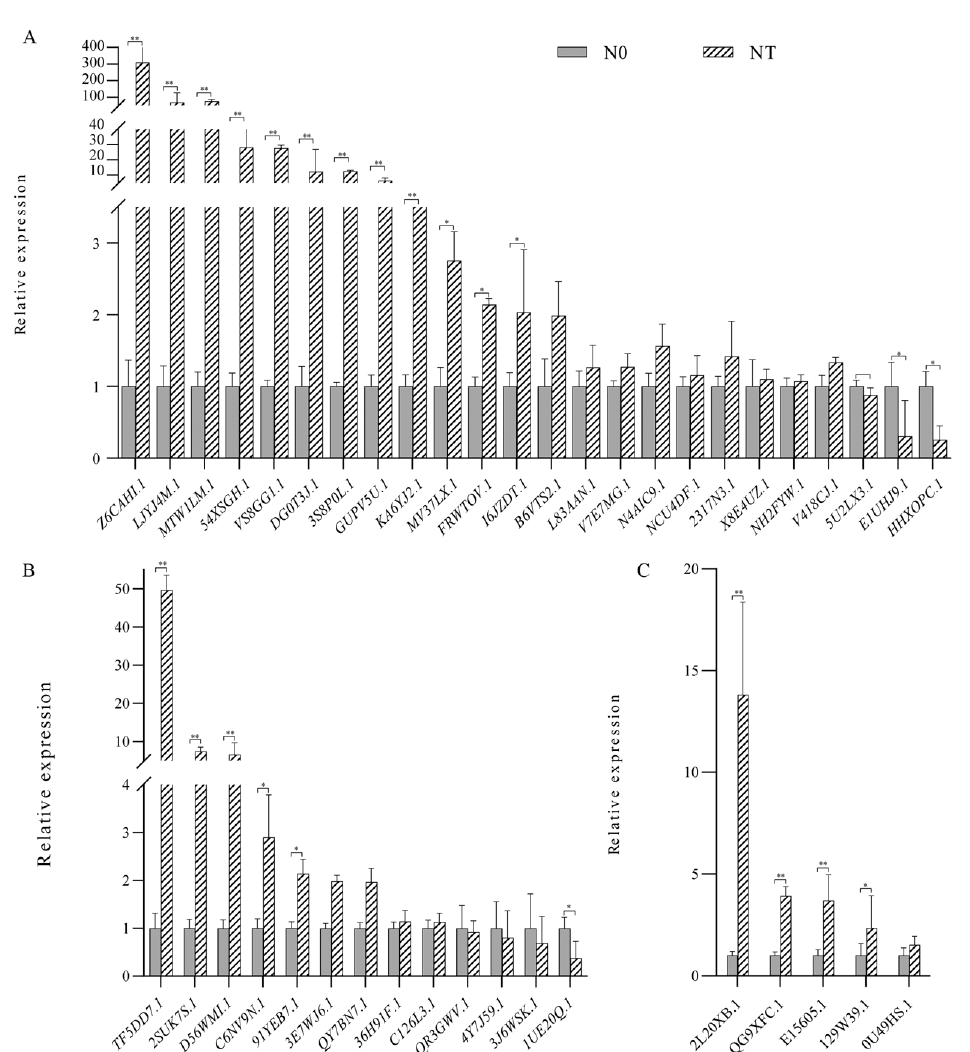
Figure 6. Quantitative real-time PCR detection of all identified GATA family members under different nitrogen levels. N0 and NT indicate the control and nitrogen level of 150 kg hm −2 , respectively. ( A – C ) indicate expression patterns of peanut subfamilies Ⅰ , Ⅱ and Ⅲ GATA genes, respectively. Asterisks indicate significant differences (Student’s t -test). ** and * indicated significant differences with p -values smaller than 0.01 and 0.05, respectively.